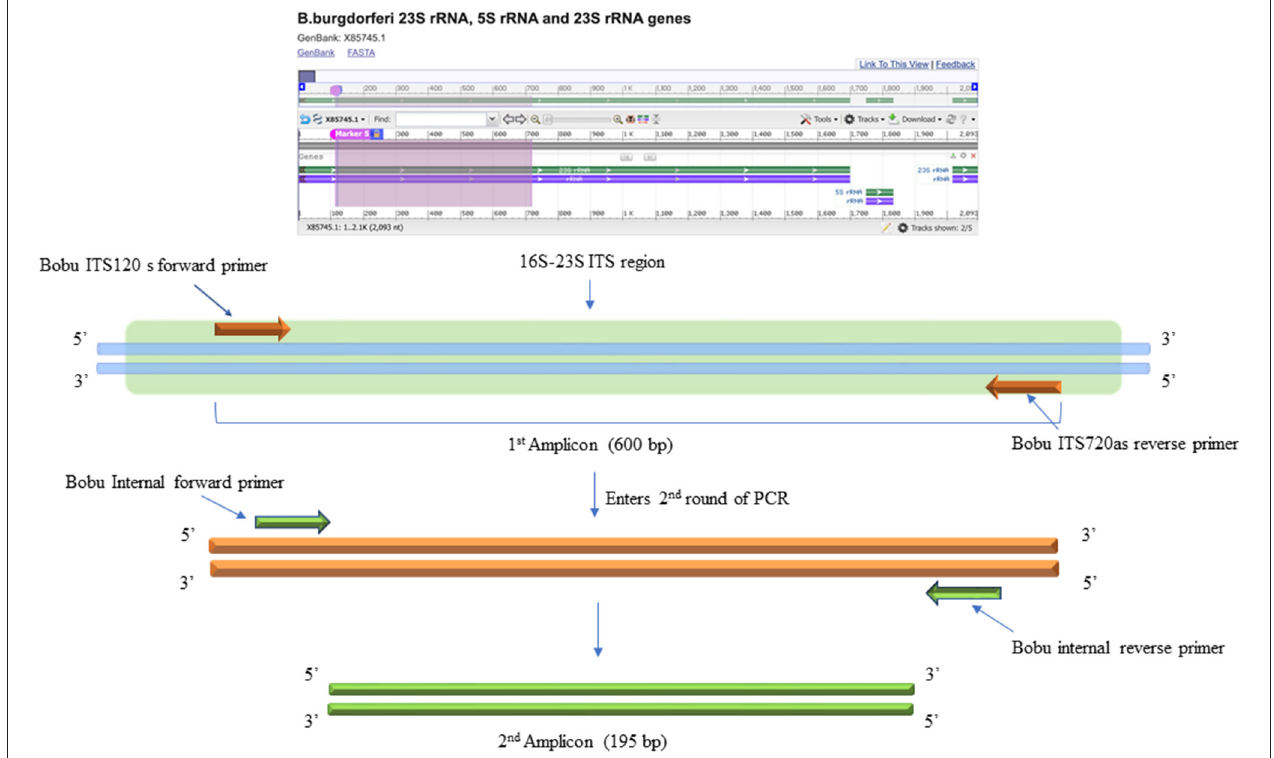
FIGURE 3 | DNA Primers targeting the 16S − 23S internal transcribed spacer (ITS) region of Borrelia burgdorferi B31 strain. Bobu ITS120s forward and Bobu ITS720as reverse primers were targeting the region of ITS of the Borrelia genomic sequence with the accession number X85745.1 from 120 to 720 bp making the first amplicon of 600 bp. These primers were designed and tested previously on Ixodes affinis and Ixodes scapularies tick species that are widely found in coastal plain region of North Carolina. To increase the specificity and sensitivity, nested primers were designed. Bobu Internal forward and Bobu internal reverse primers amplify the initial amplicon to generate a second amplicon size of 195